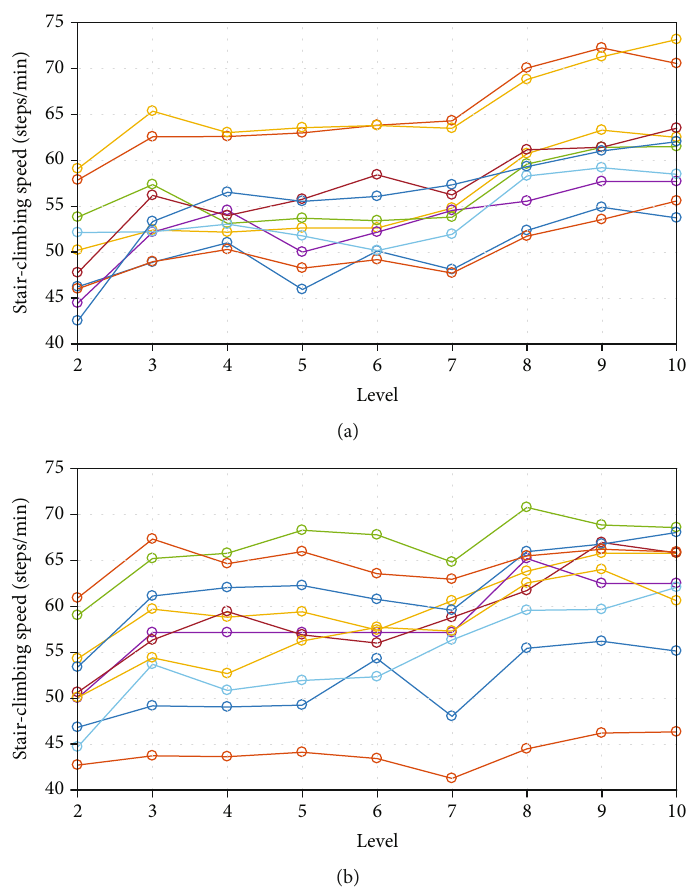
Figure 6: Average climbing speed. Climbing speed was measured under zero-impedance control (a) or climbing assistance (b)